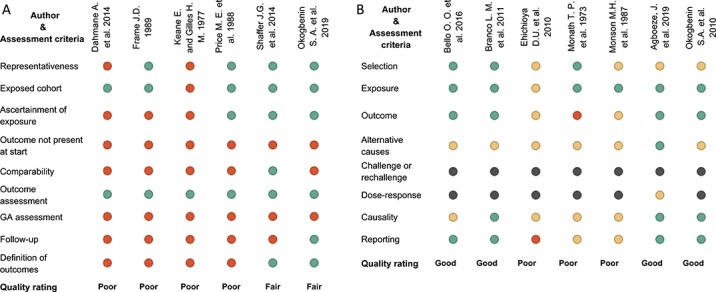
Risk of bias assessment of studies included in the systematic review and meta-analysis on Lassa fever in pregnancy. A, quality score for cohort studies; B, quality score of case reports and series. For cohort-type studies: green, star (*) and red, no star; for case series or case reports: green, yes, red, no, yellow, unclear/unsure, black, not applicable. GA, gestational age.